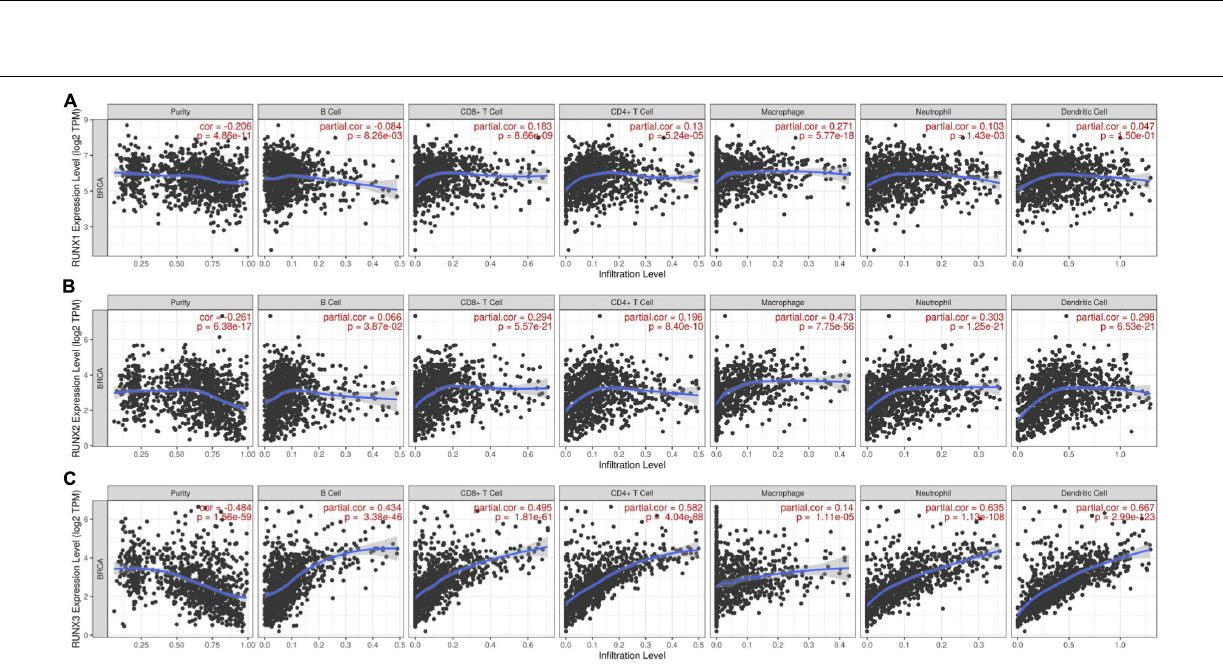
FIGURE 10 | The correlation between differentially expressed RUNXs and immune cell infiltration in breast cancer. The correlations between the transcriptional levels of (A) RUNX1, (B) RUNX2, and (C) RUNX3 with the infiltration of B cells, CD8 + T cells, CD4 + T cells, macrophages, neutrophils, and dendritic cells in breast cancer were